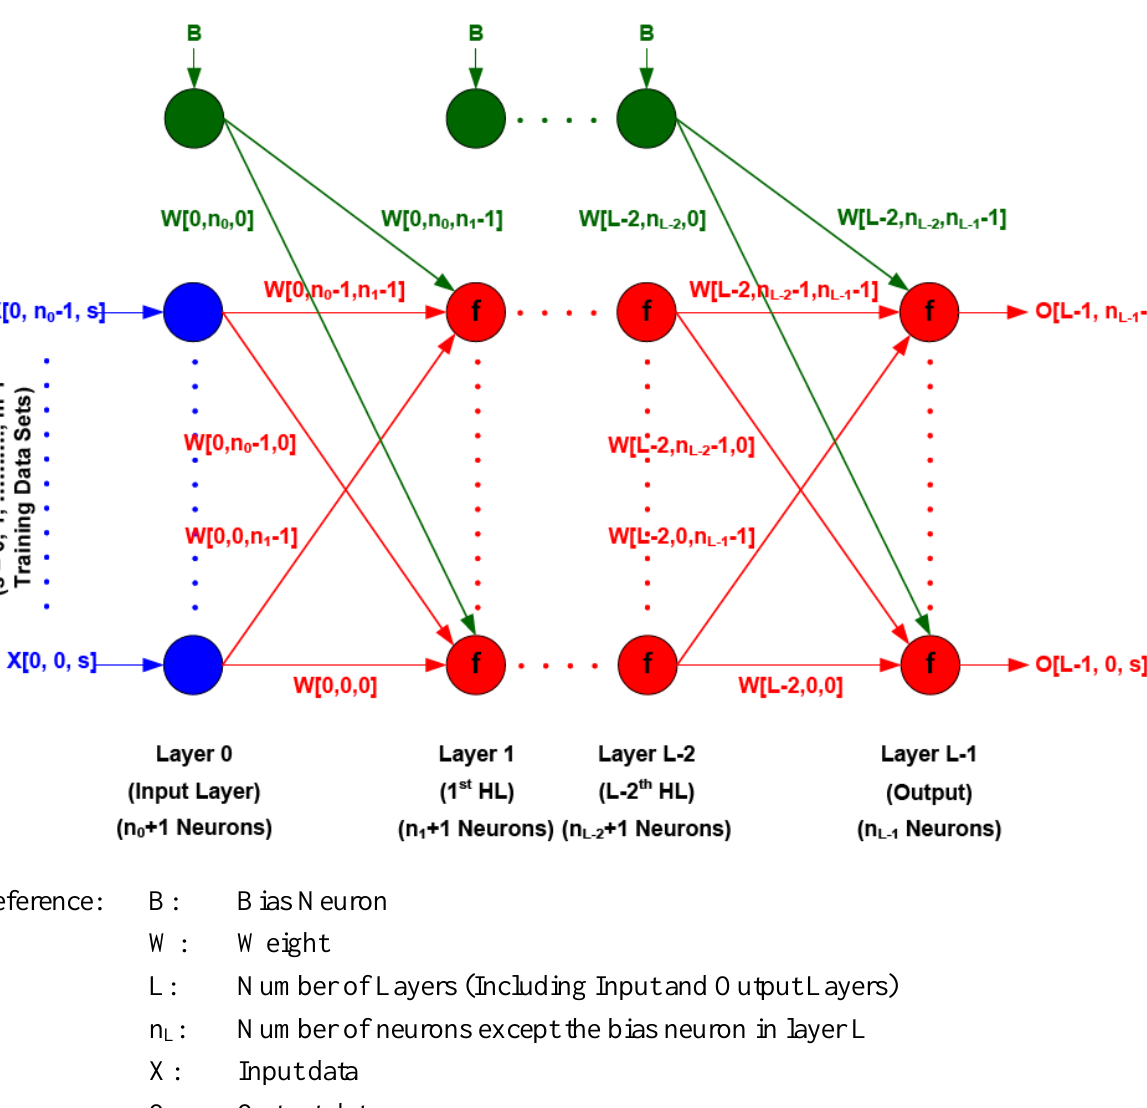
Figure 3. Architecture of multilayer back propagation artificial neural